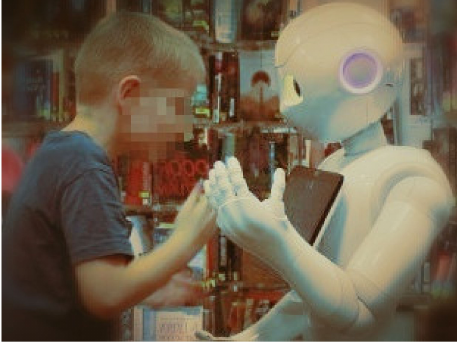
Figure 1. Pepper robot interaction with a